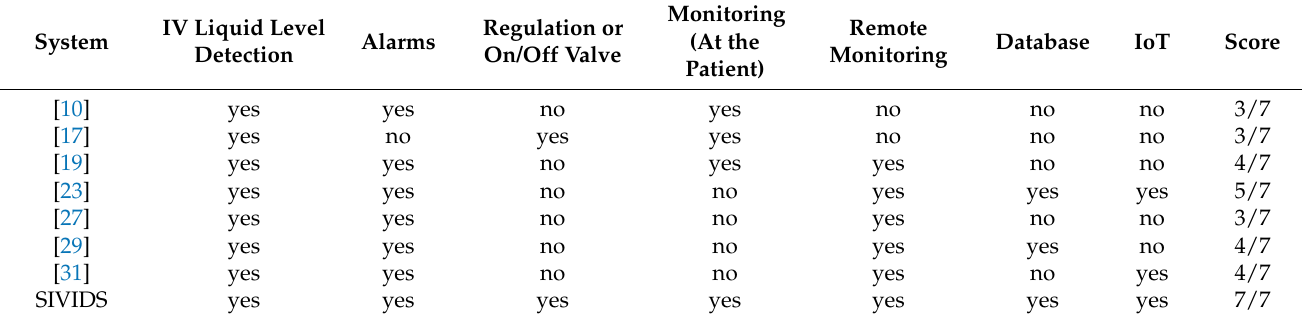
Table 6. Comparison of modern detection, signaling, and monitoring IV infusion systems. IV Liquid Level System